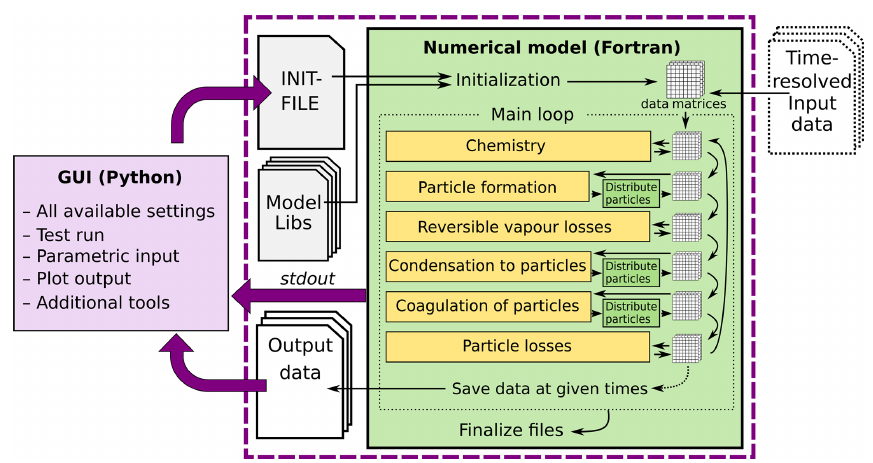
Figure 1. Schematic representation of ARCA box. The green rectangle contains the Fortran part of the model, yellow boxes contain the main modules, and the purple box is the Python graphical user interface (GUI). Purple arrows show where the interaction between the GUI and Fortran executable takes place. GUI interacts with the Fortran model by writing the INITFILE (top purple arrow), repeating the screen output of the numerical model (middle purple arrow, stdout ) and plotting the output data (bottom purple arrow). The dashed purple rectangle is the minimal configuration needed to run ARCA, and input data are not strictly necessary as parametric input can also be